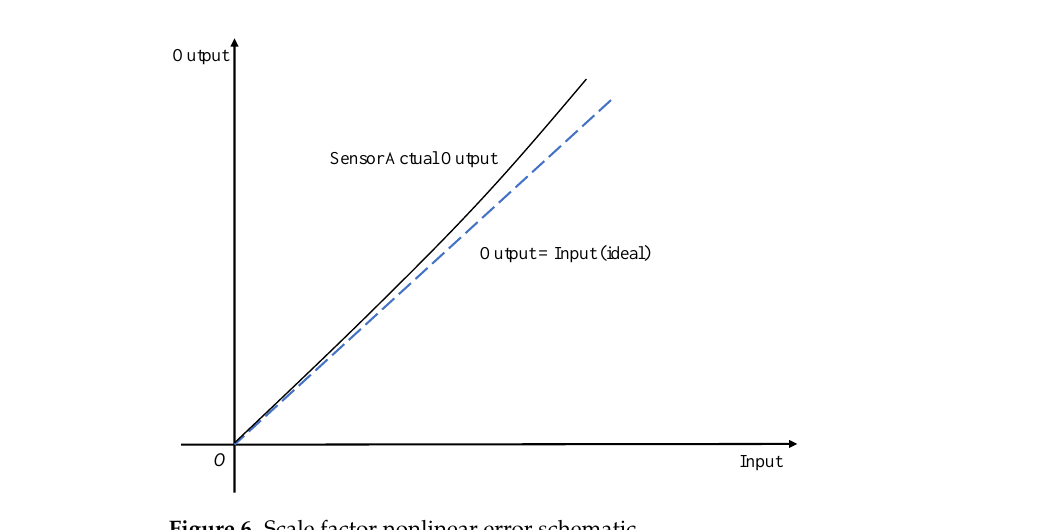
Figure 6. Scale factor nonlinear error schematic.